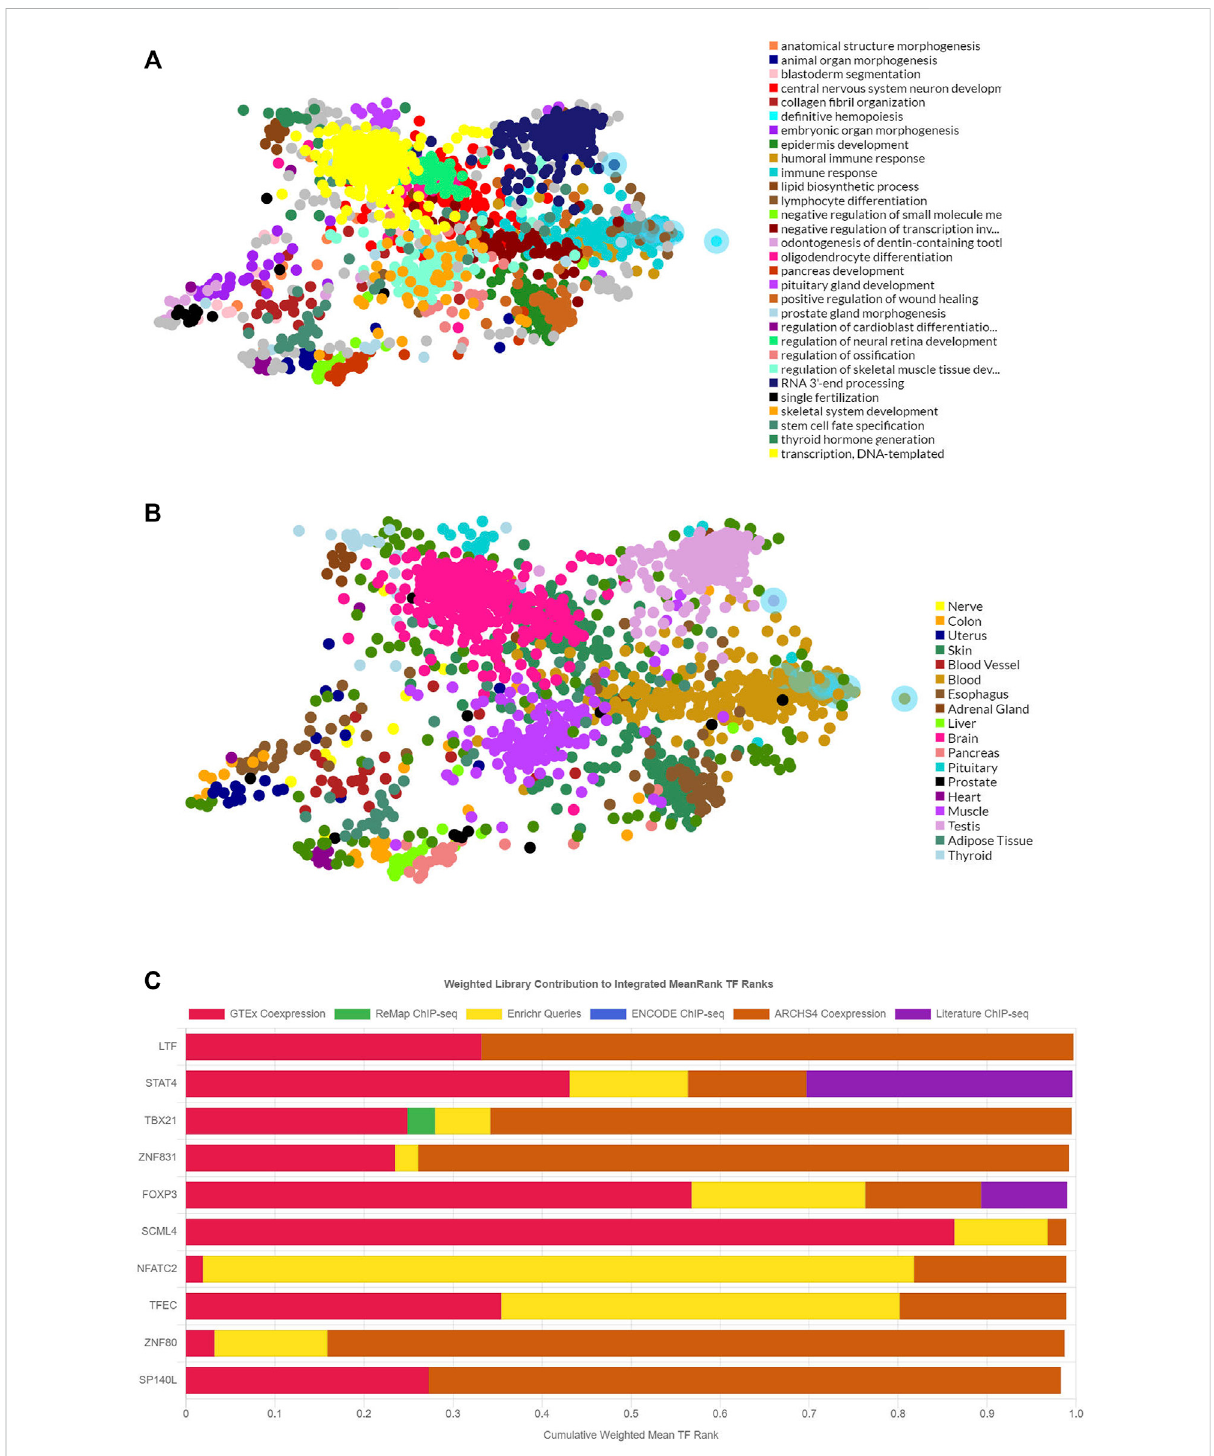
FIGURE 4 The functions, locations, and the top-ranking TF targets of the 317 DEmRNAs. (A) The main biological functions of the 317 DEmRNAs. (B) The tissue distributions oftheTF targets ofthe317 DEmRNAs. (C) Thetop 10 TF targets ofthe317DEmRNAs.DEmRNAs, differentiallyexpressedmRNAs; TF: transcriptional